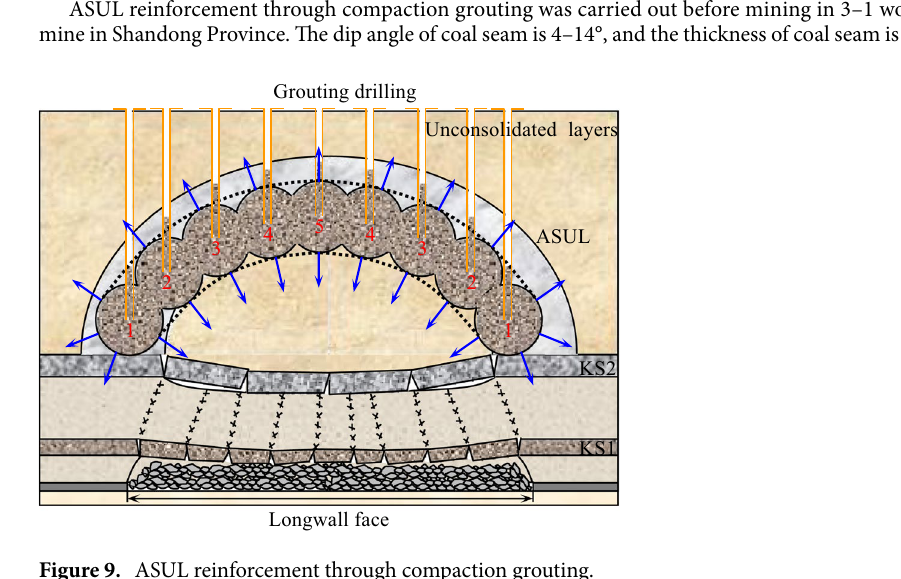
Figure 9. ASUL reinforcement through compaction